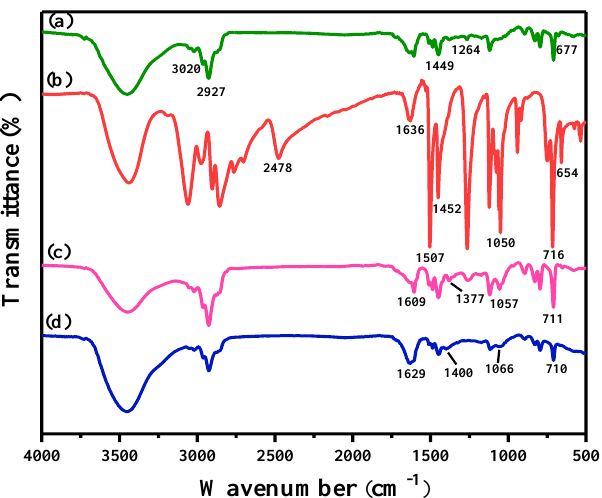
Figure 1. The characteristic bands located at 677 cm − 1 and 1264 cm − 1 in the spectrum of PS- Cl (Figure 1a) corresponded to the stretching vibrations of C-Cl and the bending vibra- tions of CH 2 -Cl, respectively [24]. The characteristic peak at 2478 cm − 1 found in the spec- trum of DMTD (Figure 1b) corresponded to the stretching vibrations of -SH [31]. Compar- ing the spectra for DMTD and PS-DMTD showed that the peak at 2478 cm − 1 disappeared in the spectrum of PS-DMTD (Figure 1c), and new peaks appeared at 1055 cm − 1 and 1605 cm − 1 , which were assigned to the stretching vibrations of C-S [32] and the stretching vi- brations of C=N [33], respectively. The appearance of these new peaks supported that the Cl groups in PS-Cl were replaced by DMTD. After the adsorption of Pd (II), the peaks of both C=N and C-S shifted to high frequencies (4 cm − 1 and 7 cm − 1 , respectively) (Figure 1d), suggesting that the N and S atoms were involved in the adsorption of Pd (II) [25].